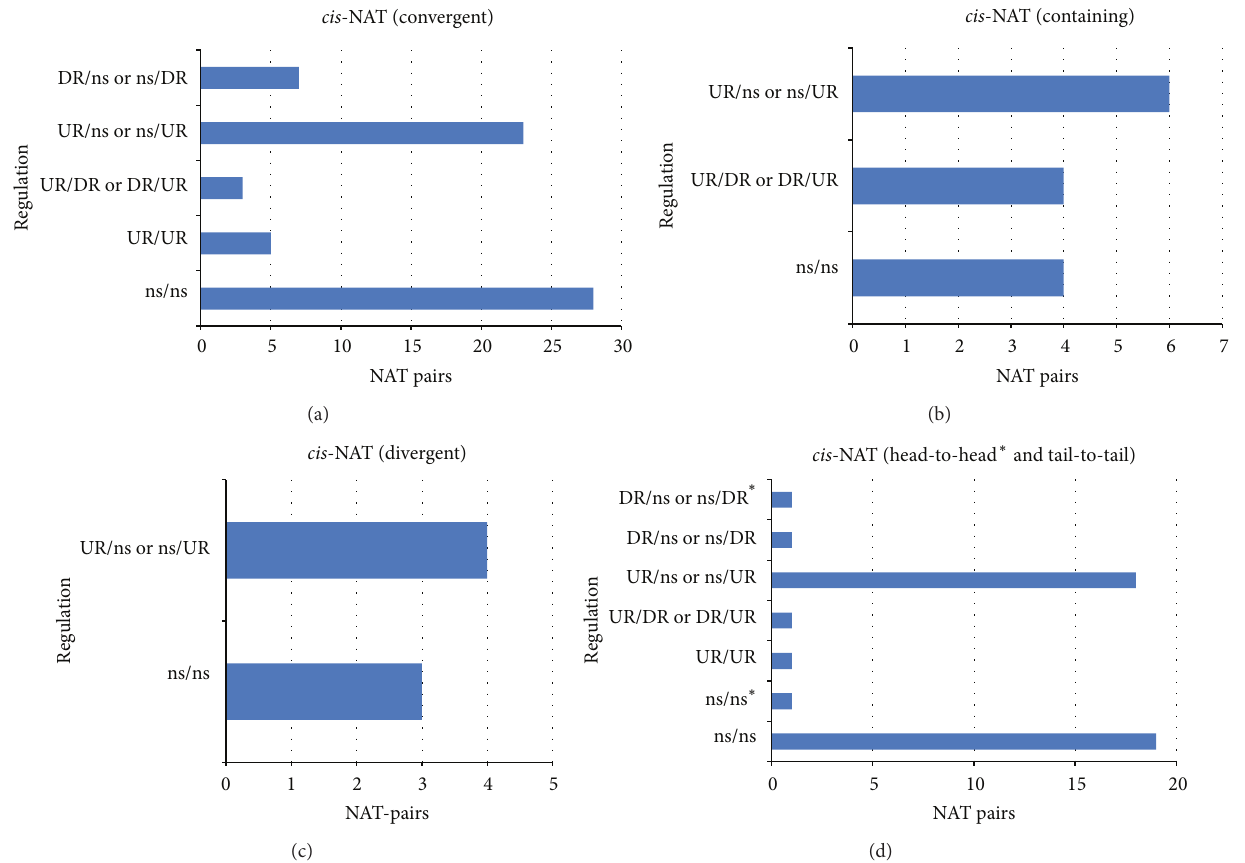
Figure 1: Numbers of cis -NAT pairs observed in five classes (PlantsNATsDB database) showing pair regulation based on soybean SuperSAGE unitags mapped in both sequences of each pair. The unitags were originated from library infected with Phakopsora pachyrhizi or not and expressed as UR (upregulated), DR (downregulated), or ns (nonsignificant at 𝑃 < 0.05